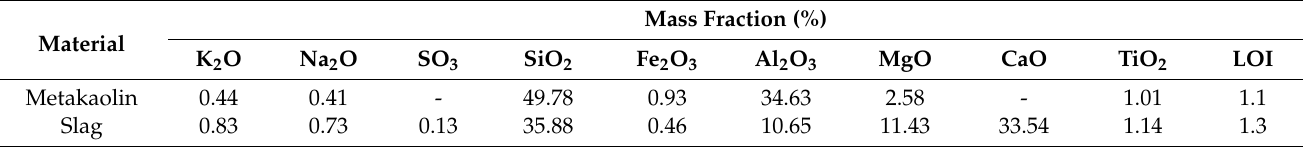
Table 1. Chemical composition and physical index of metakaolin and